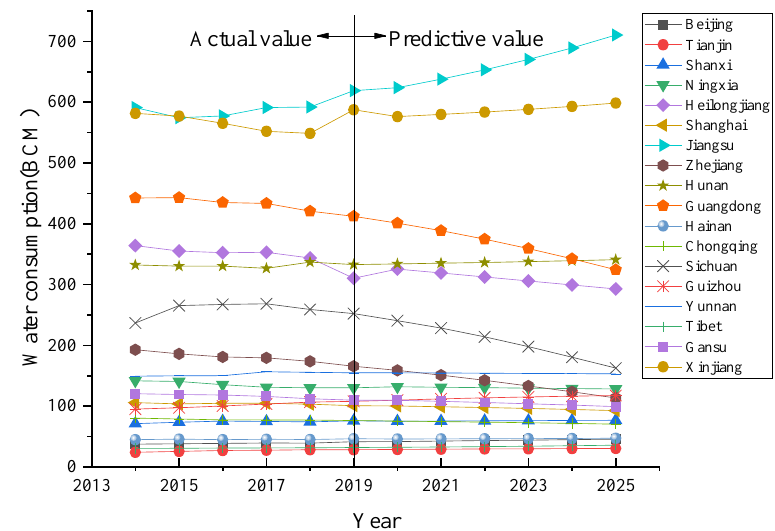
Figure 5 . Water consumption in tertiary industry dominated regions. Figure 5. Water consumption in tertiary industry dominated